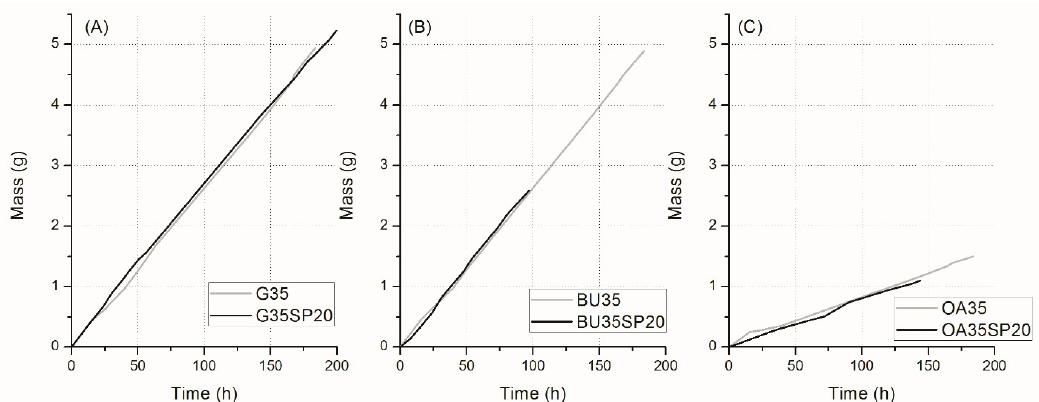
Figure 4. Mass loss of water through films of gluten plasticized with 35% of glycerol ( A ), 1,4-butanediol ( B ), and octanoic acid ( C ), with and without 20 php of microalgal biomass. Materials 2019 , 12 , x FOR PEER REVIEW